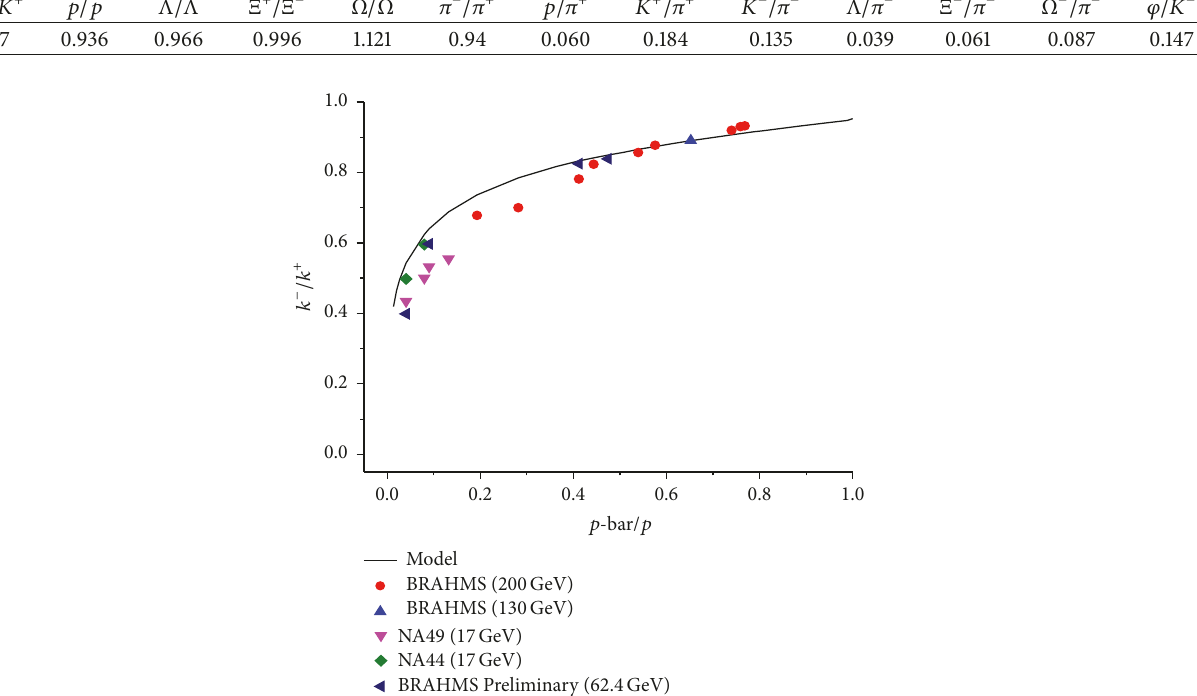
prediction whereas the colored shapes represent the different experimental data points as mentioned in the Figure